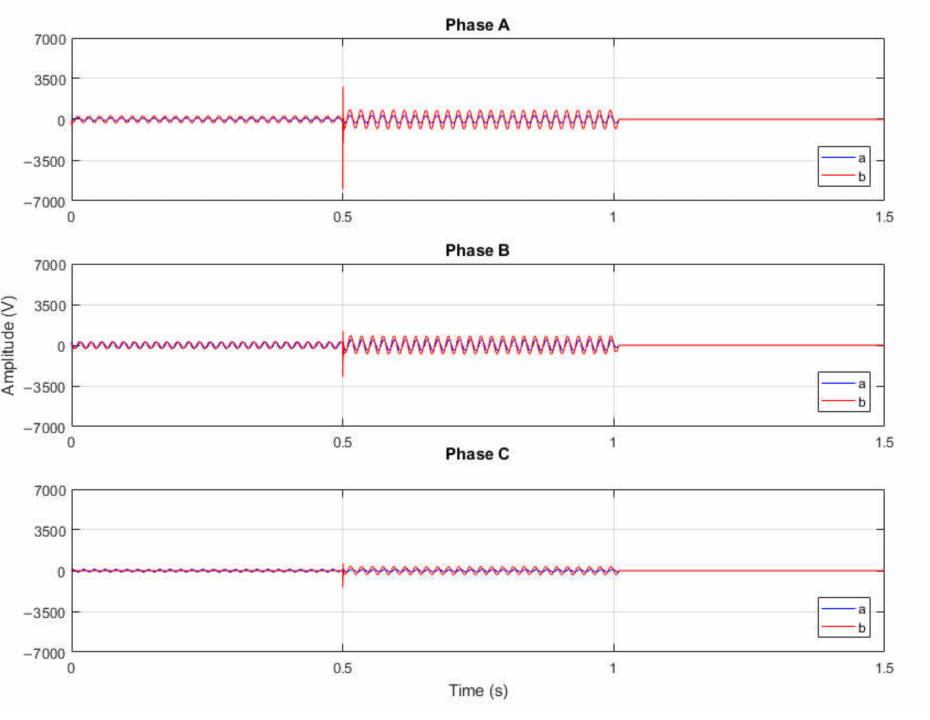
Figure 4. Voltage waveforms in three-phase cable line screens in Terminal